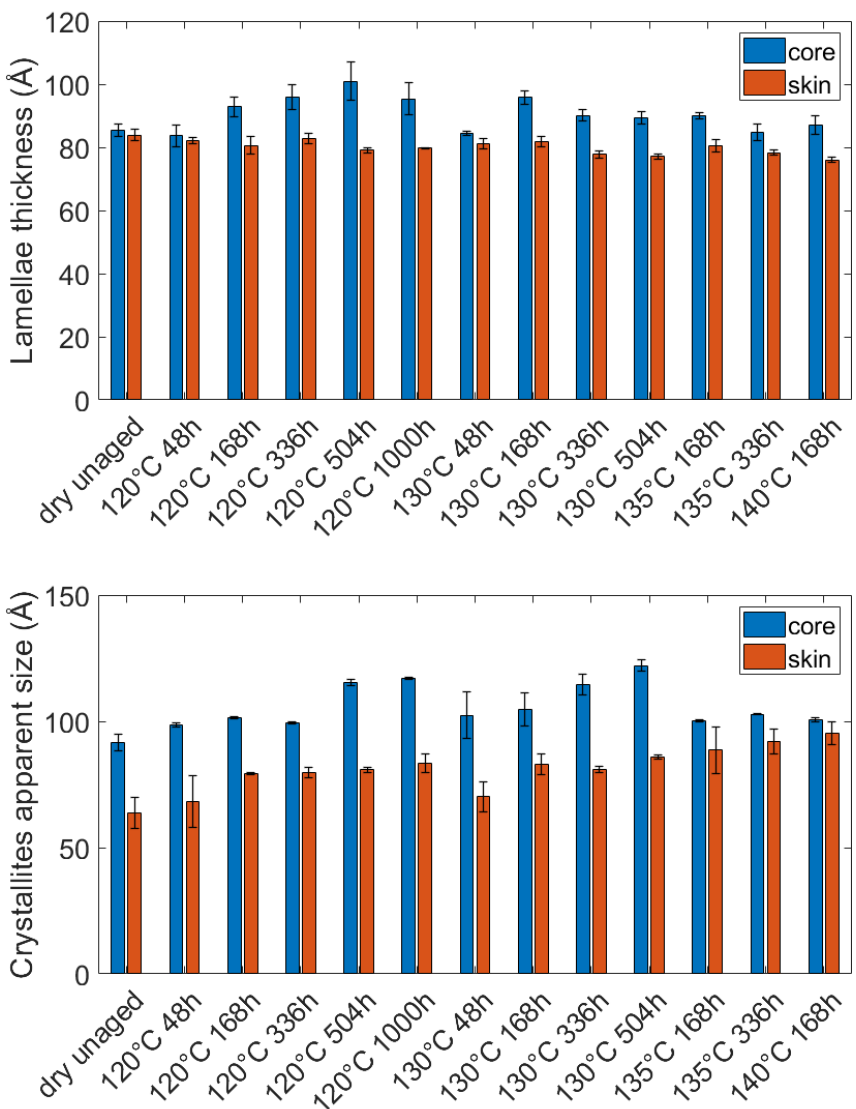
Figure 19. Comparison of the dimension of the crystalline entities at the core and at the surface: Lamellae thickness and crystallites apparent size.